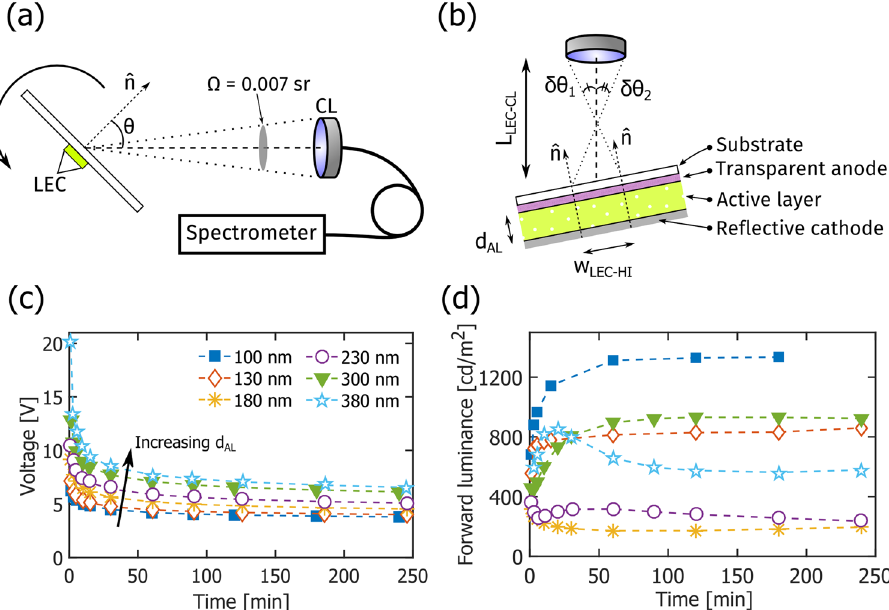
Figure 1. ( a ) A schematic of the custom-built automatic spectroscopic goniophotometry setup defining the viewing angle ( θ ) and the solid angle of collection (Ω). ( b ) A schematic of the LEC device structure and the positioning of the collimating lens (CL). The FWHM spread in the viewing angle, based on the half-intensity width of the LEC, w LEC-HI , is Δθ ≡ δθ 1 + δθ 2 . Note that the dimensions are not drawn to scale. ( c ) The temporal evolution of the operating voltage for LEC devices with different active-layer thickness (d AL , as specified in the inset) during galvanostatic driving at a current density of 250 A/m 2 . ( d ) The corresponding temporal evolution of the forward luminance, as collected within a small solid angle of 0.007